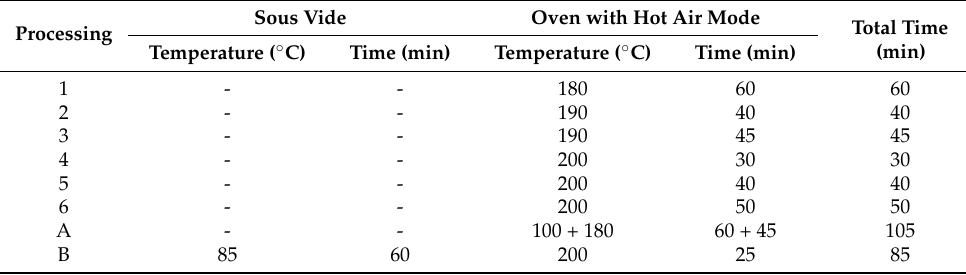
Table 1. Parameters used in the optimization of the thermal processing from rind to